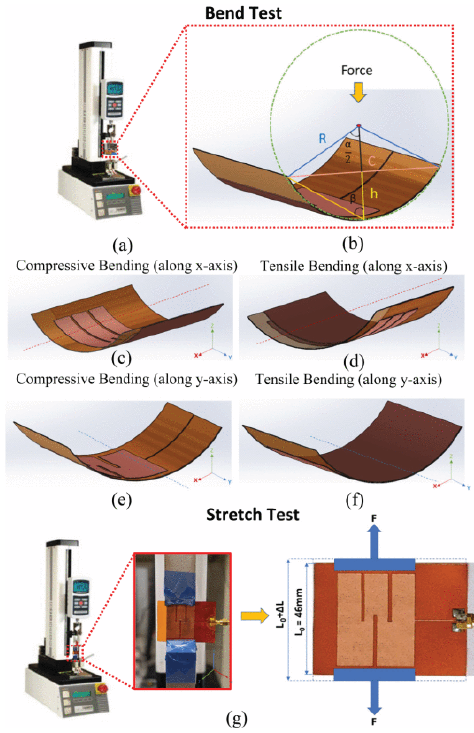
Figure 17. Experiment process of compressive and tensile bending and stretching the antenna along the x-axis and y-axis [23]. the x-axis and y-axis